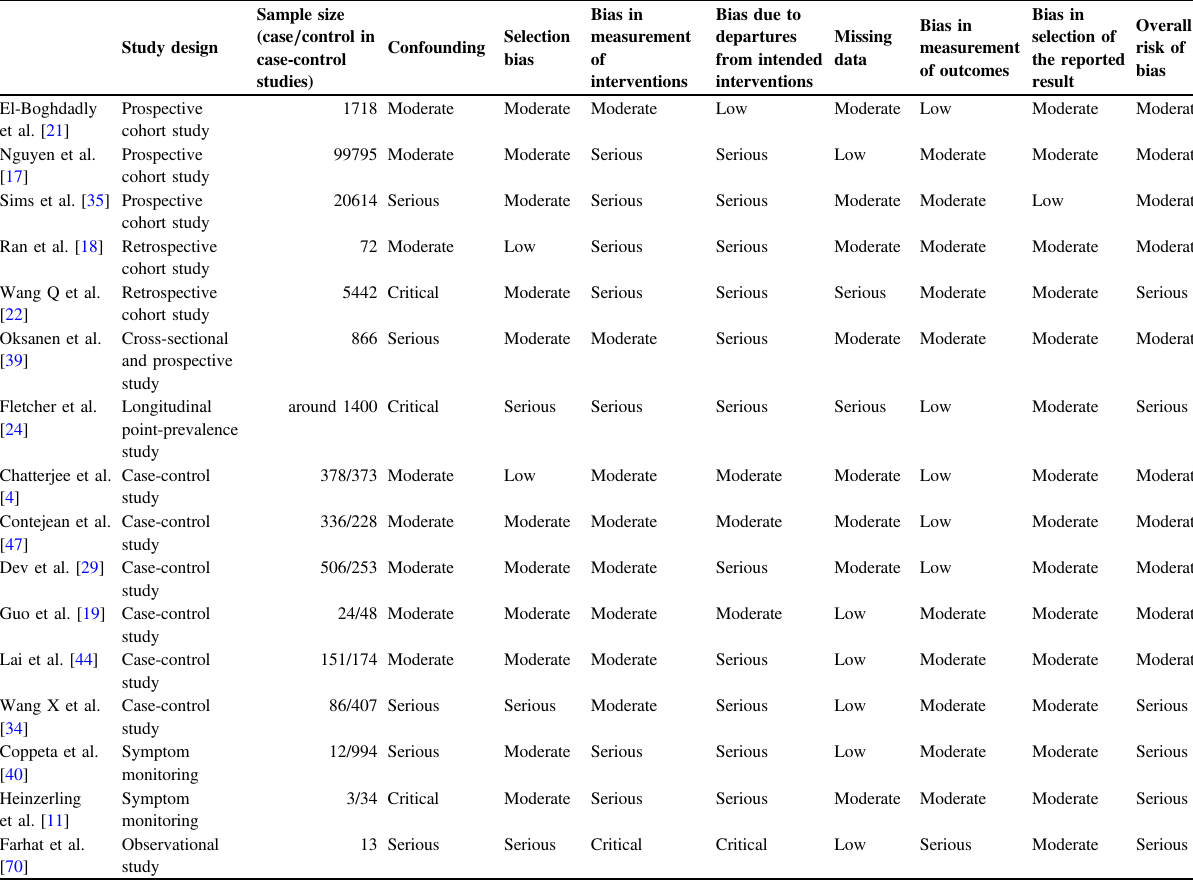
Table 2 Risk of bias assessment on cohort and case-control studies for the investigation on PPE